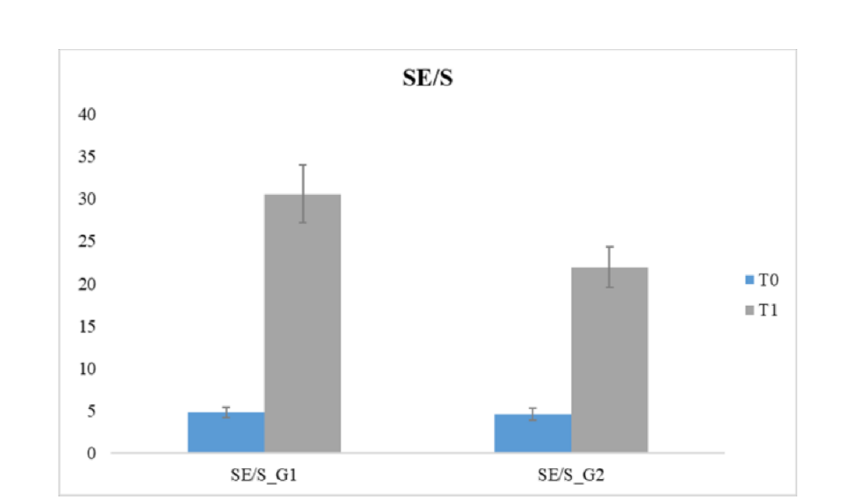
Figure 4. Comparison of the groups at T0 together with T1 on task 4 (ESSE). Comparison of the two groups between T0 and T1 at task 4